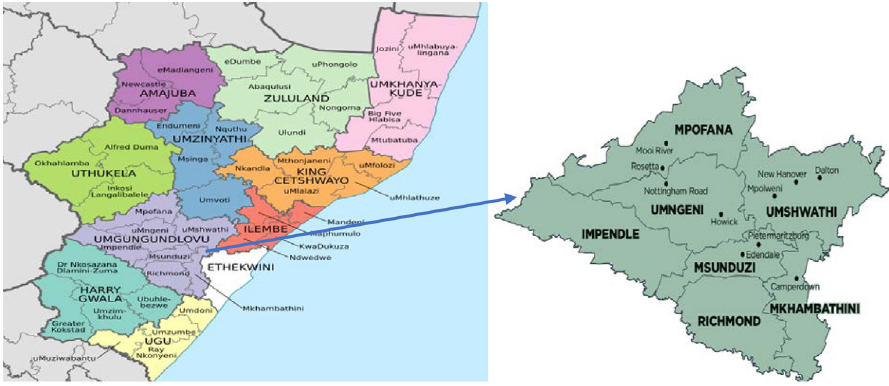
Fig 1. Sub-districts of uMgungundlovu District Municipality within Kwa-Zulu Natal Province. Source: File:Map of KwaZulu-Natal with municipalities named and districts shaded (2016). https://en.wikipedia.org.